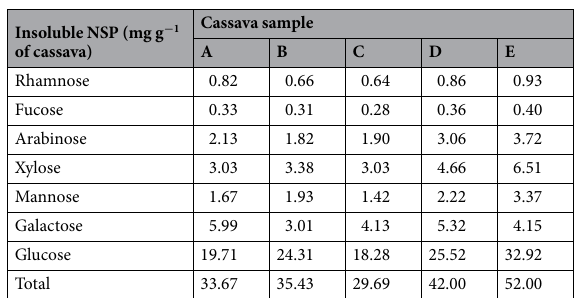
Table 2. Content of insoluble neutral non-starch polysaccharide (NSP) sugars in cassava (n =